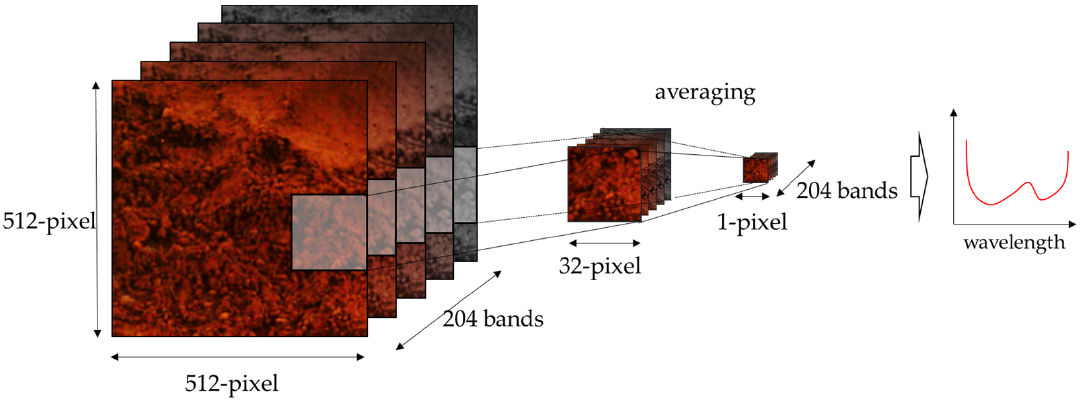
Figure 7. Processing of the hyperspectral data for deep learning.